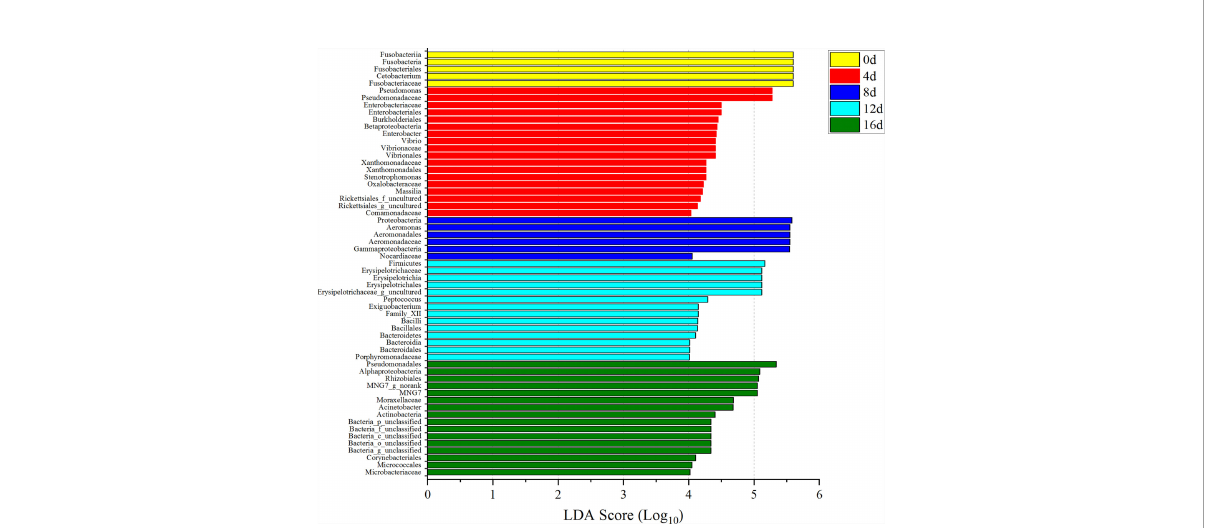
FIGURE 8 Microbial indicator groups in different durations of swimming exercise with LDA >4.0. Yellow represents non-exercised group, red represents exercised for 4d group, blue represents exercised for 8d group, blue-green represents exercised for 12d group, and green represents exercised for 16d